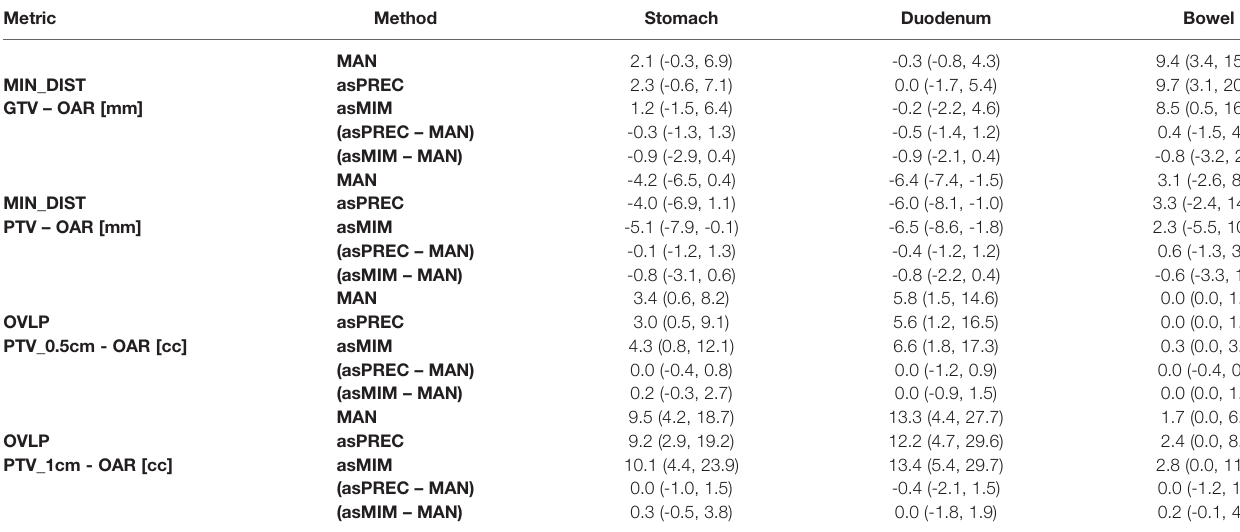
Results are presented for both manual (MAN), and autosegmented contours using Precision (asPREC) and MIM (asMIM), as well as the difference between auto and manual contours.